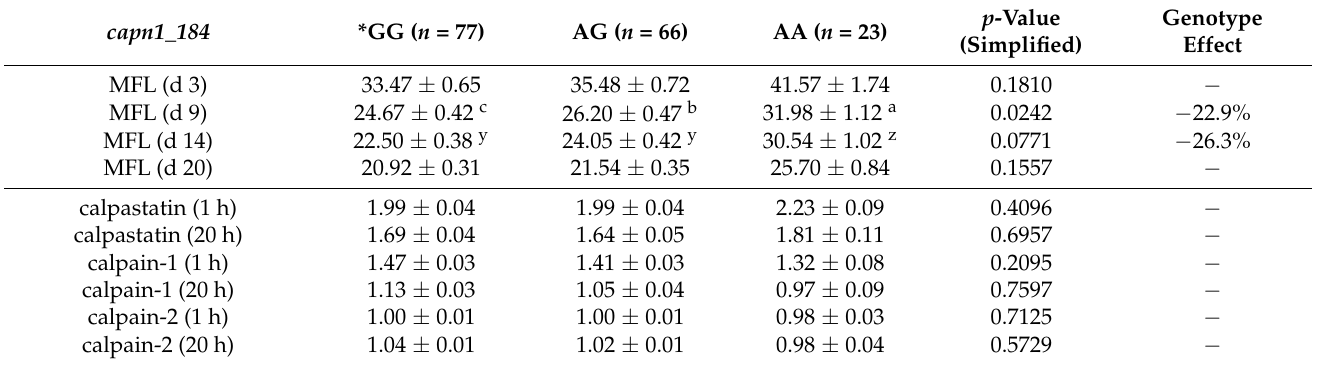
Table 5. The effects of genotype of the capn1_184 SNP on the tenderness phenotype, myofibril fragment length (MFL) of representative purebred South African beef bulls during three to 20 days of ageing and on the muscle protease enzyme system during the first 20 h